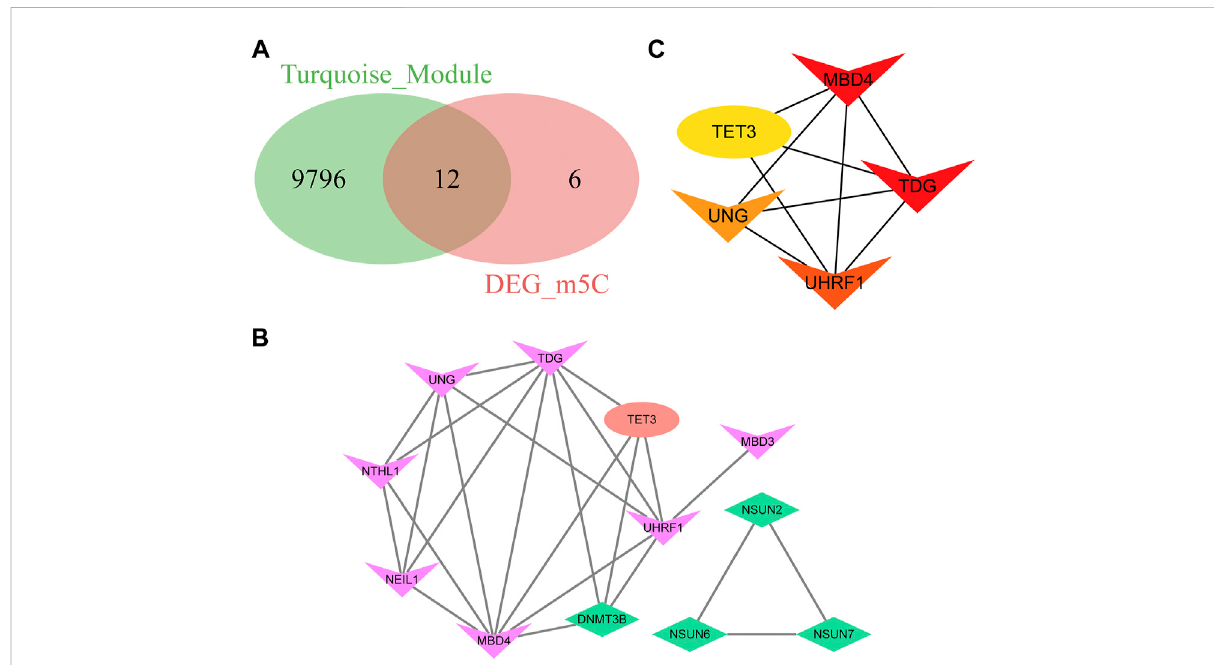
FIGURE 9 Protein-proteininteractionandidenti fi cationofhubgenes. (A) Venndiagramofthedifferentiallyexpressedm5C-relatedgenesintheturquoise module. (B) Protein-protein interaction network of the differentially expressed m5C-related genes in the turquoise module. (C) CytoHubba plugin analysis of the top fi ve hub genes with the degree algorithm.